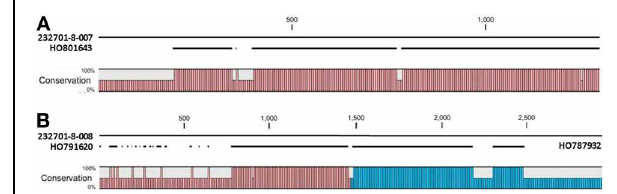
FIGURE 7 | Alignments of P. acutifolius ESTs with the predicted CDS sequence from the Niemann Pick locus in OAC-Rex. The percent conservation between three accessions from a drought stressed P. acutifolius library (Narina and Bhardwaj, unpublished) and the OAC-Rex genes 232701-8-007 (A) and 232701-8-008 (B) are shown. EST HO801643 contained a stop codon at the same position as the OAC-Rex gene, neither HO0791620 nor HO787932 were complete and did not contain start or stop codons. Their positions in the alignment are denoted by red and blue bars in the Conservation graph, respectively.